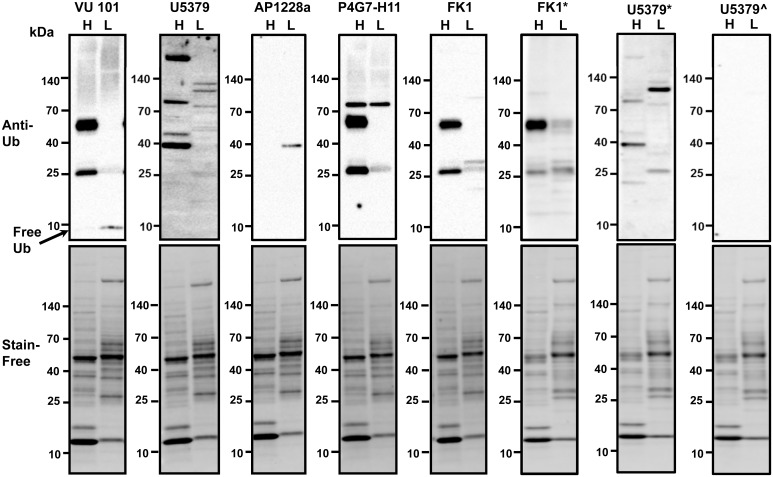
Comparison of anti-ubiquitin antibodies.Heart and liver lysates (20 μg each) were investigated by Western blotting using five commercially available anti-ubiquitin antibodies (VU101, U5379, AP1228a, P4G7-H11, FK1). Arrow shows location of free unbound ubiquitin. Stain-free staining of total proteins loaded was used as the normalization control. H, heart; L, liver. BSA was used as the blocking reagent for the blot labeled FK1* while non-fat milk was used as the blocking reagent in all the other blots shown. All antibodies were used at a dilution of 1:1000 except for blots labeled U5379* and U5379^ which were used at dilutions of 1:100 and 1:2000 respectively.